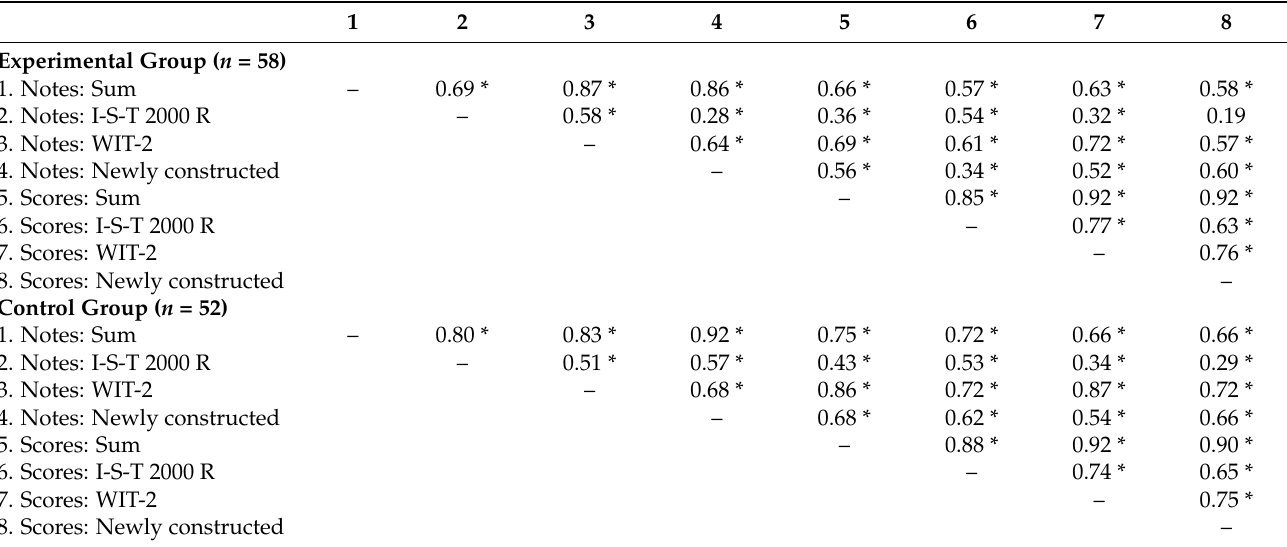
Table 2. Correlations between all variables in each group.